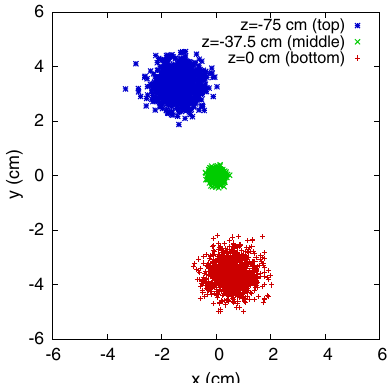
FIG. 11. The x - y plot at three longitudinal positions ( z ¼ (cid:2) 75 cm , z ¼ (cid:2) 37 : 5 cm , and z ¼ 0 cm ) with an incident proton beam of normalized emittance 25 (cid:2) mm - mrad and Twiss parameters of (cid:3) x ¼ (cid:3) y ¼ 0 , (cid:1) x ¼ 10 cm , and (cid:1) y ¼ 10 cm at z ¼ (cid:2) 37 : 5 cm .